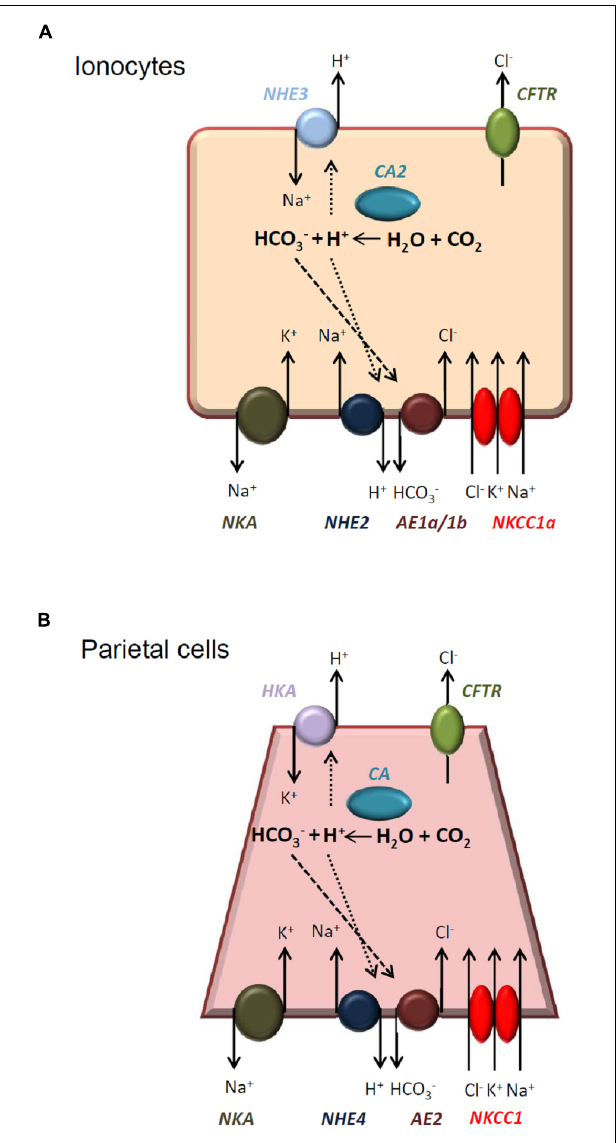
FIGURE 9 | Illustrated models of the acid-secretion by medaka ionocytes and mammalian parietal cells. Medaka ionocytes (A) and mammalian parietal cells (B) are both acid-secreting cells and have similar transport mechanisms. See “Discussion” for a detailed comparison. NKA, Na + -K + -ATPase; NHE, Na + /H + exchanger; AE, anion exchanger; NKCC, Na + -K + -Cl − cotransporter; CA, carbonic anhydrase; HKA, H + /K + -ATPase; CFTR, cystic fibrosis transmembrane conductance